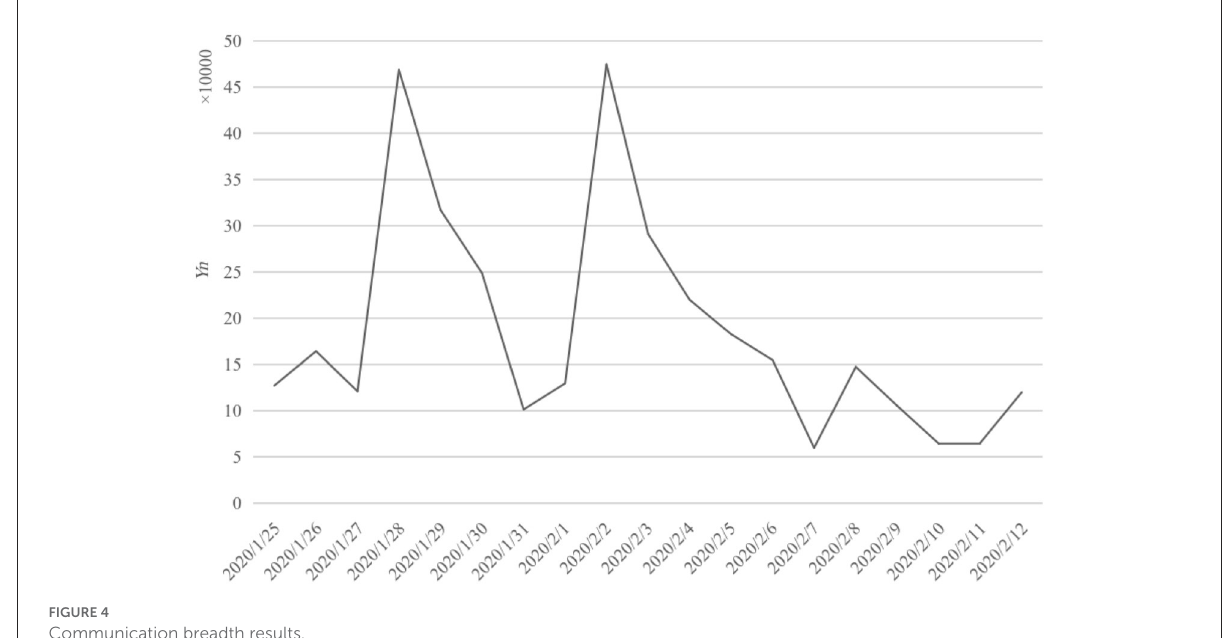
FIGURE4 Communication breadth